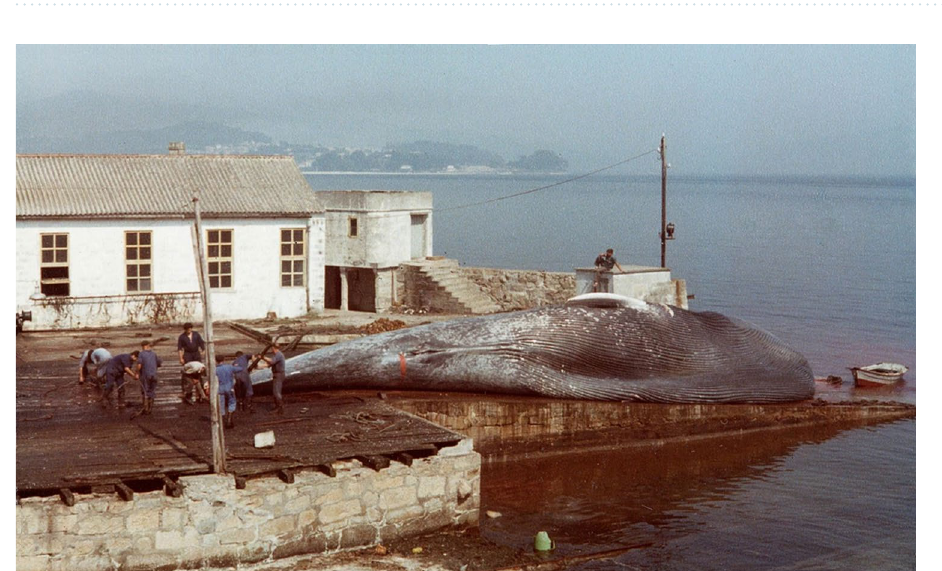
Table 2. Details of the blue whale catches recorded, with catch date, body length, sex, and presence/absence (Y/N) of foetus, company responsible for the capture, factory in which the individual was flensed, source, and whether and how the catch is reported in the official IWC statistics database 4 .